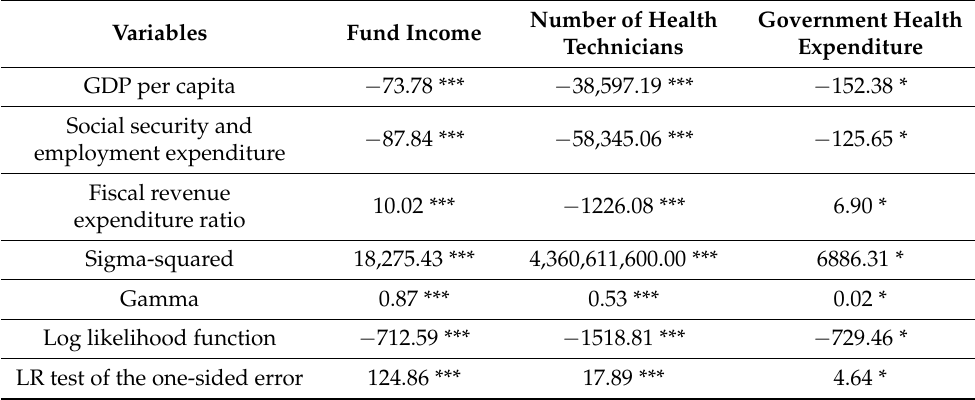
Table 5. Regression results of the SFA model at stage 2.